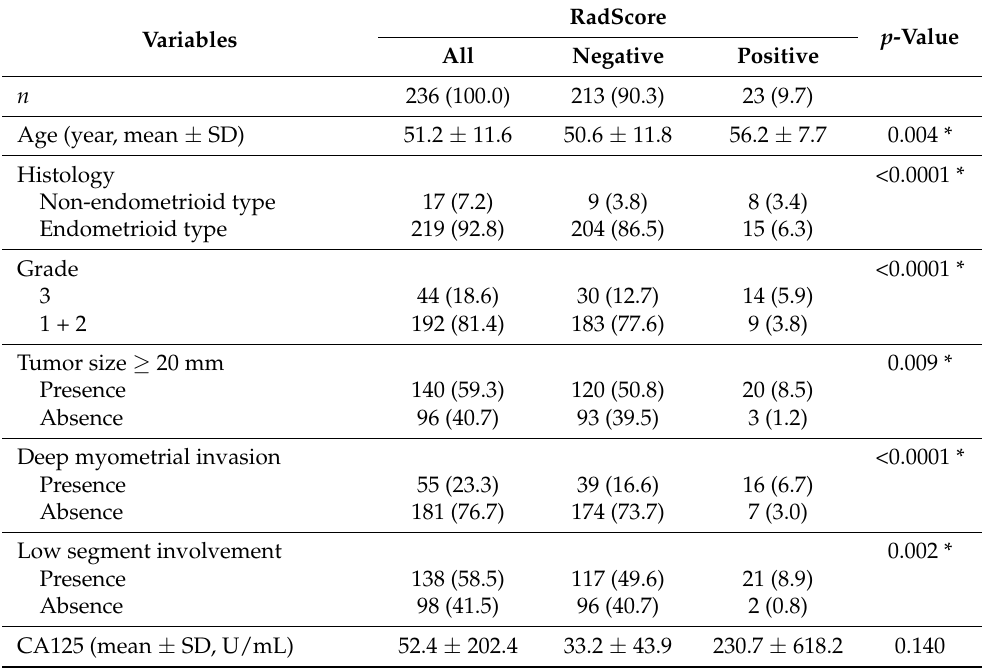
Table 1. Demographics of the study